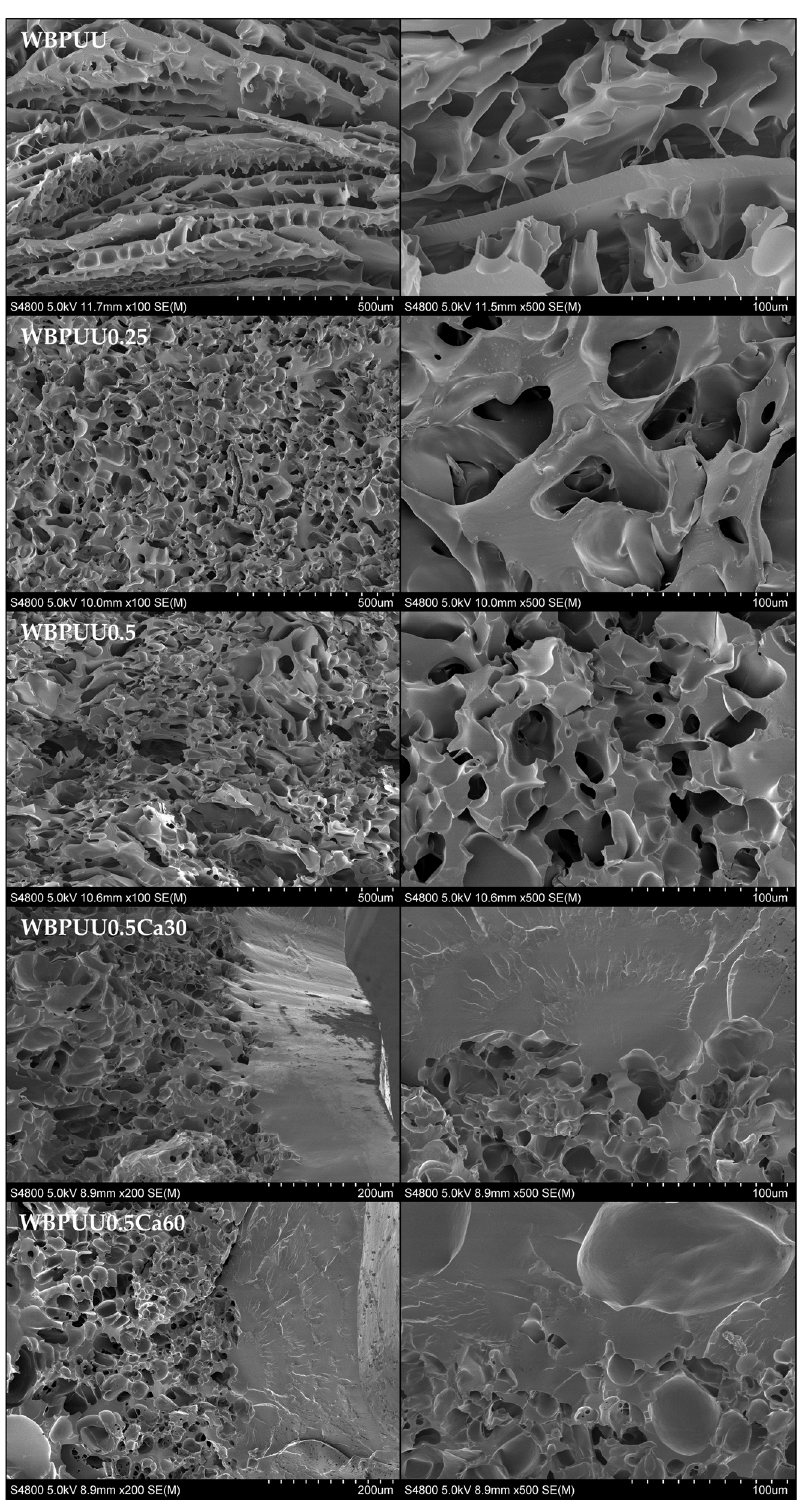
Figure 5. SEM images of the different WBPUU/CNC and WBPUU/CNC scaffolds immersed in CaCl 2. in CaCl 2